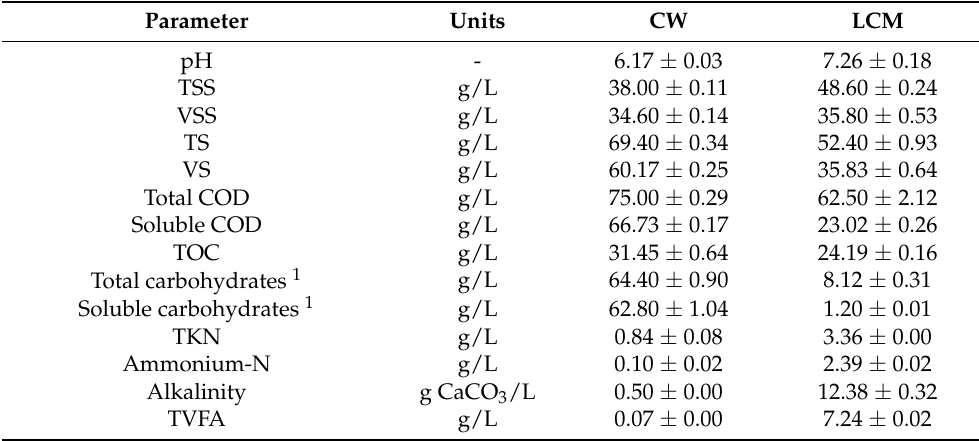
Table 1. Chemical composition of CW and LCM.